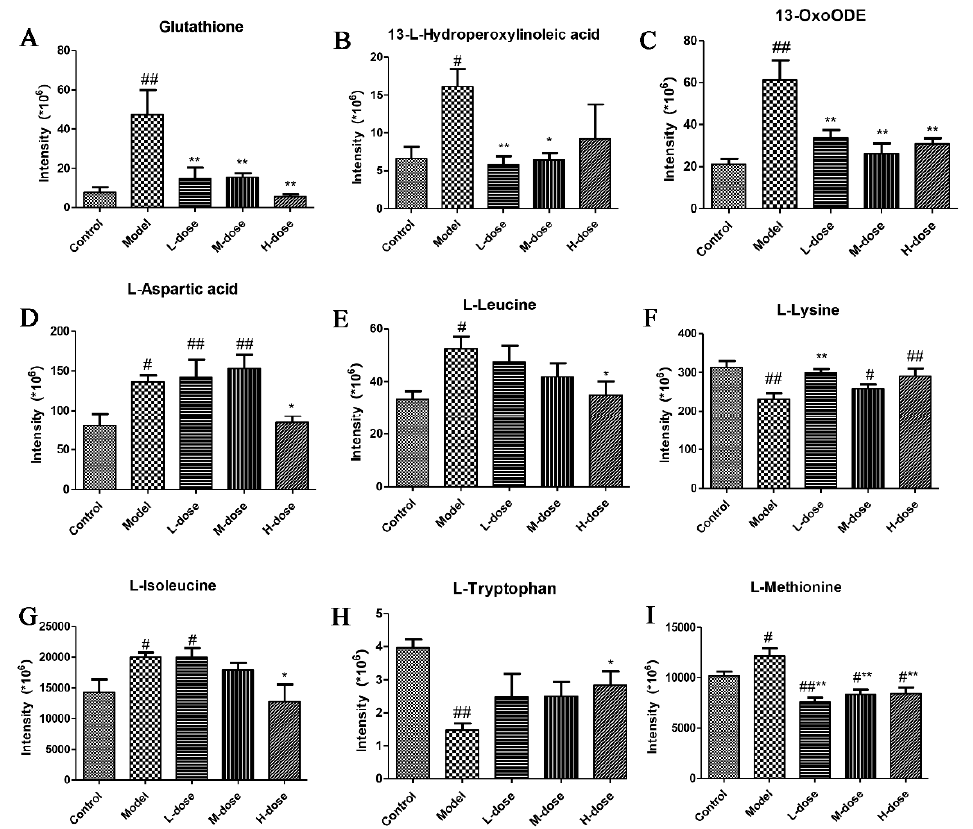
Figure 12. Serum levels of nine metabolites. ( A ) Glutathione, ( B ) 13-L-hydroperoxylinoleic acid, ( C ) 13-oxoODE, ( D ) L-aspartic acid, ( E ) L-leucine, ( F ) L-lysine, ( G ) L-isoleucine, ( H ) L-tryptophan and ( I ) L-methionine. Data represent at least three independent experiments. The results are shown as the mean ± SEM. # p < 0.05, and ## p < 0.01 compared with the control group; * p < 0.05, and ** p < 0.01 compared with the model group; #** means # and **; ##** means ## and **.